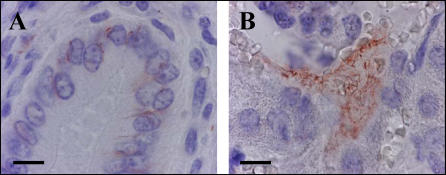
In Vivo Expression of Loa22 in Liver and Kidney of Guinea Pigs Infected with L. interrogans Serovar Lai(A) Liver, (B) kidney. Histopathologic sections were stained by immunochemistry using Loa22 antiserum (×1,000). Intact organisms were found in biliary ducts (A) and in large number in Bowman's spaces and proximal tubules (B). Scale bar = 20 μm.